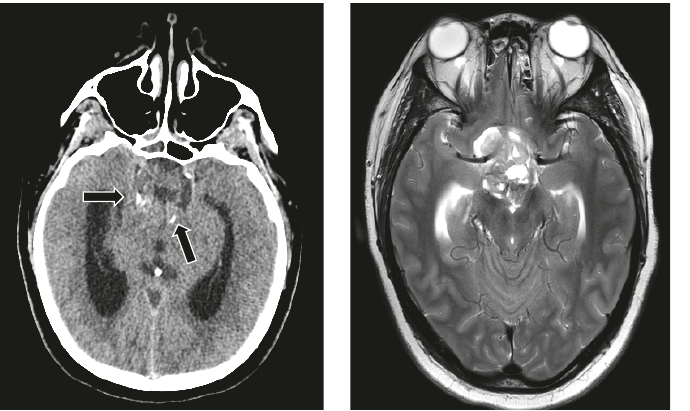
(b) AxialT2weightedimageshowingthe extra axial mass within the suprasellar cisternwithinternalcystsandsolidcom- ponents that are near isointense to gray matter (Figure 1(b))